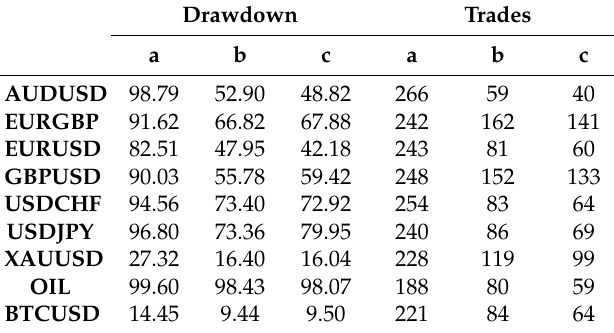
Table A2. Additional results of experiments (a), (b), and (c).